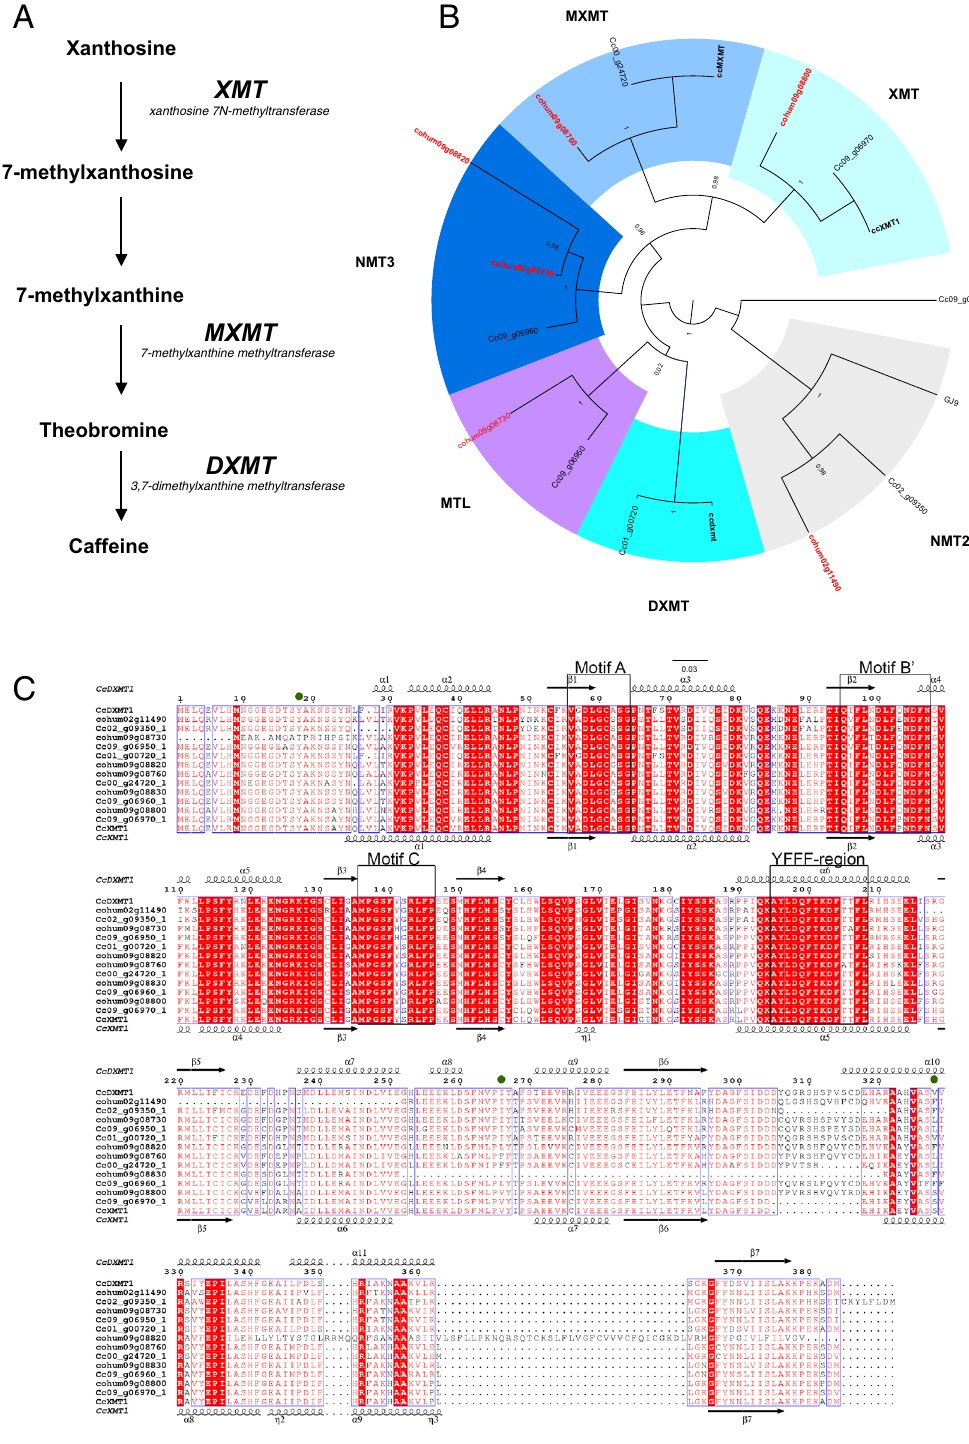
Figure 4. Evolution of NMT genes in C. humblotiana and C. canephora. ( A ) Representation of the methylation steps of the caffeine biosynthesis in coffee. ( B ) Phylogenetic analysis of complete NMT proteins in C. humblotiana , C. canephora and Gardenia jasminoides . Reference proteins for XMT (A4GE69), MXMT (jx978517) and DXMT (jx978516) are from C. canephora . IDs of C. humblotiana proteins are in red and IDs of C. canephora (in black) are named as in the genome annotation release. The protein Cc09_g07000 (NMT4) is used as outgroup. Numbers indicate the aLRT branch support. ( C ) Multiple sequence alignment of the C. canephora and C. humblotiana MNT proteins. Secondary structure plot is given for CcDXMT (CcDXMT (above) and CcXMT (below). The SAM binding motifs (A, B’ and C) and the conserved YFFF region are marked by boxes, and green circles identify crucial residues in substrate recognition and